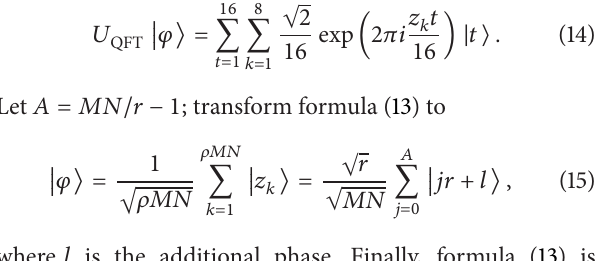
fingerprint image, composed of all the white dots to match